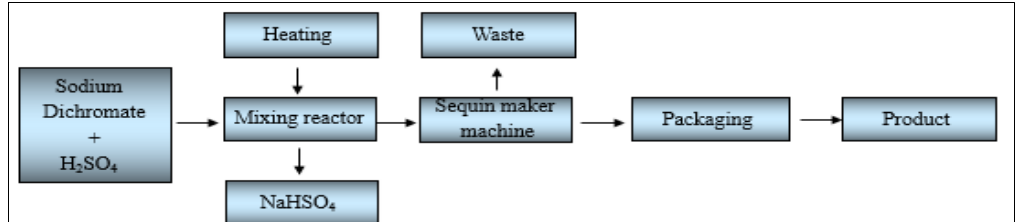
Figure 5: The layout of units of the chromic acid